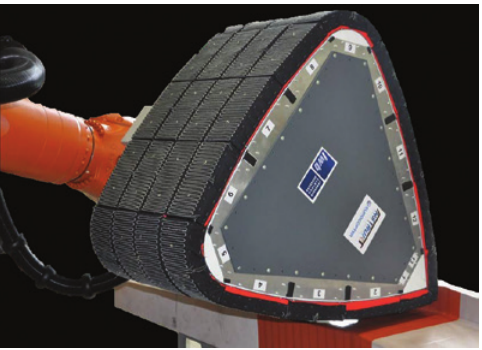
Figure 10: Robot-based rollforming setup for an axially curved profile preform with U-shaped cross-section. Source: Premium Aerotec GmbH.